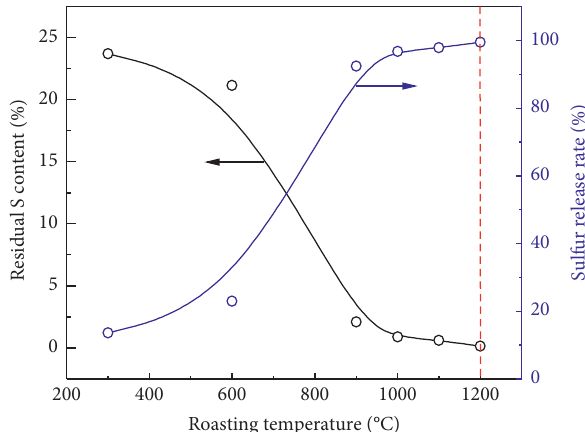
Figure 8: Effect of roasting temperature on sulfur release rate and residual S content (conditions: roasting time � 30min and air flow � 1.0L/min).